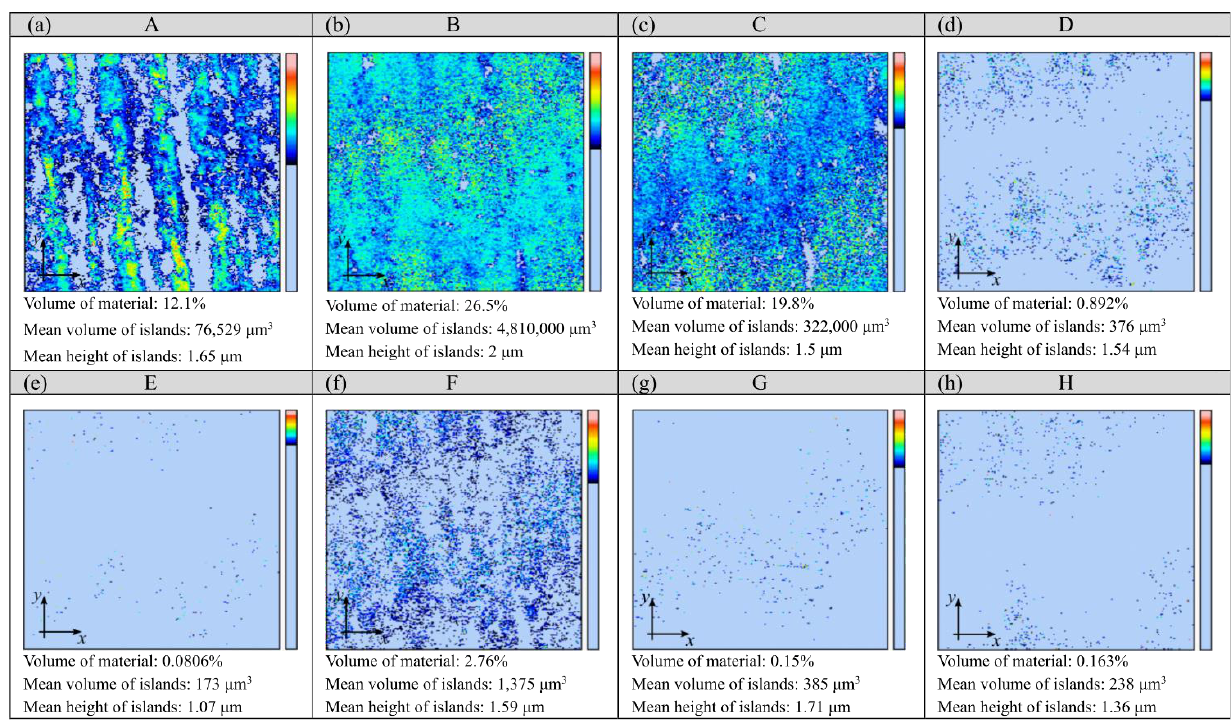
Figure 3. Results of an analysis of islands (number and area of islands) isolated on glass workpieces (marked with uppercase letters A–H) under eight diverse smoothing process conditions ( a – h ).